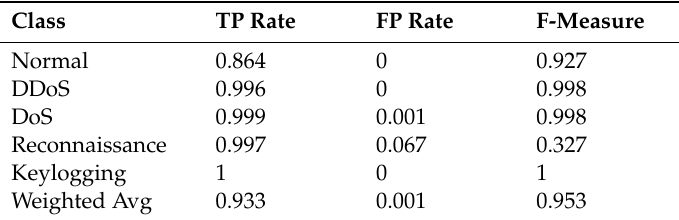
Table 9. Detailed accuracy of C5 decision